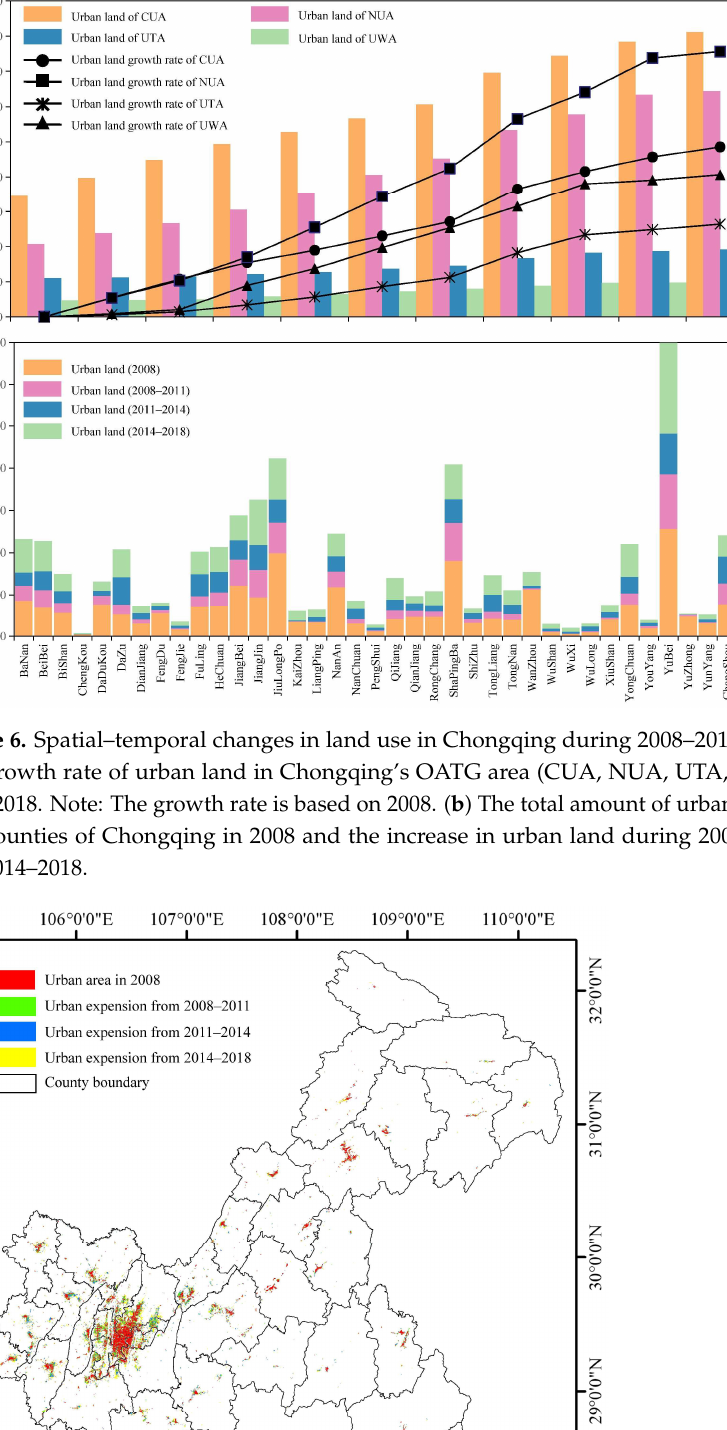
Figure 7. Map of the urban land expansion of districts and counties in Chongqing during 2008–2018, including urban land area in 2008 and urban land growth area during 2008–2011, 2011–2014, and 2014–2018. In the UTA, the built-up area of Wanzhou was much higher than that of other districts and counties in the same region. In 2008, the built-up area of Wanzhou was 33.75 km 2 , while the built-up area of most areas in the UTA was very small, with 1.25 km 2 in Chengkou, 4.93 km 2 in Fengjie, and 2.75 km 2 in Wushan. During the ten years, the built-up area of Wanzhou increased by 46.19 km 2 , but its annual growth rate was only 3%, which was the lowest in the UTA. Although the built-up area of Wuxi was still less than 10 km 2 , the annual growth rate of Wuxi was 16%, the highest in the region. The size of the built-up area in the UTA decreased from southwest to northeast. In the UWA, only Qianjiang and Xiushan had built-up areas exceeding 10 km 2 in 2008. The built-up areas of other districts and counties were lower, with 3.56 km 2 in Pengshui and 2.5 km 2 in Wulong. From 2008 to 2018, the built-up areas of Qianjiang and Xiushan reached 28.94 km 2 and 22.56 km 2 , respectively. Pengshui and Wulong had higher growth rates of